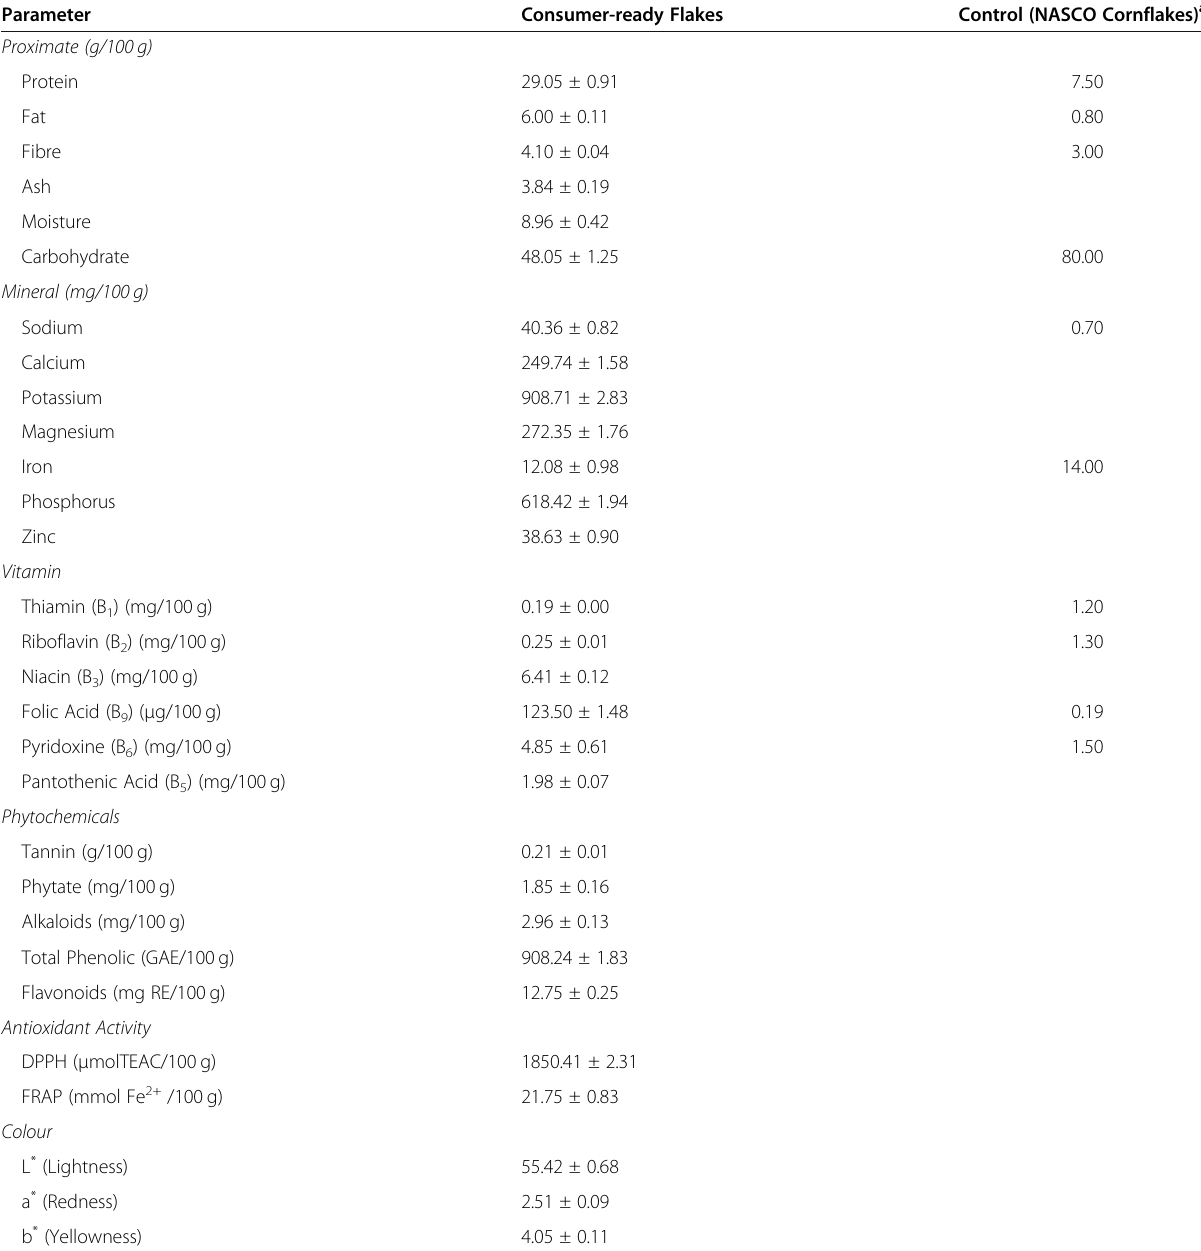
Table 4 Nutritional properties of consumer-ready flakes from high-protein soymeal, amaranth and modified corn starch produced under optimal condition